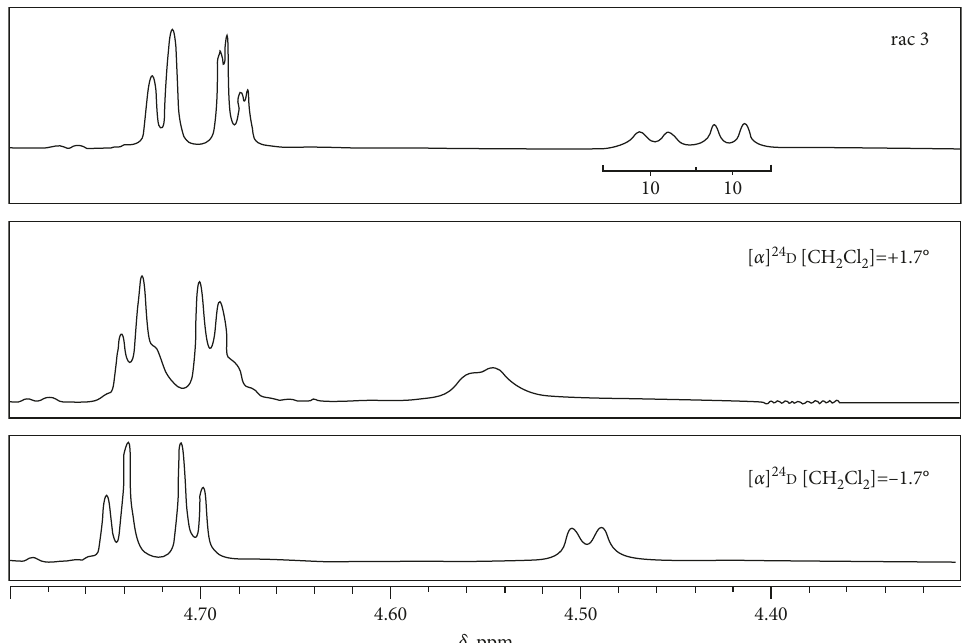
Figure 2: Fragments of 1H NMR spectra of racemic alcohol 3 and its enantiomers in the presence of a shift